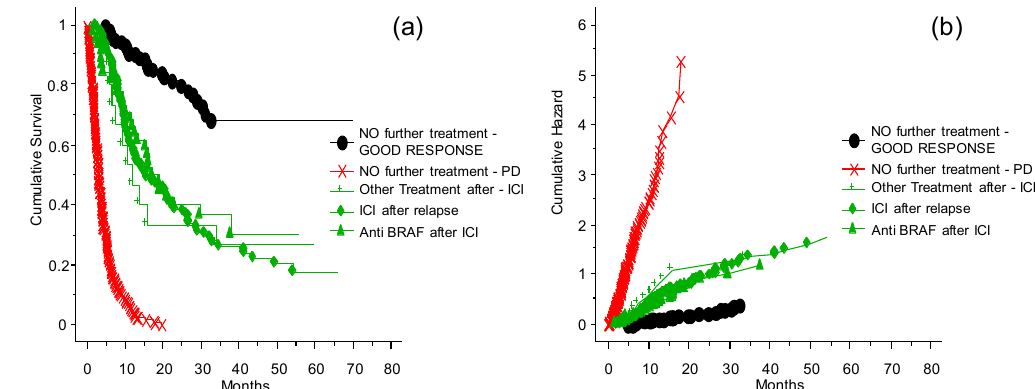
Figure 5. The probability of survival and risk for patients who relapsed after the ICI program at the INT-NA. Panel ( a ) shows probability of survival, panel ( b ) shows risk. Subsequent line of treatment or no further treatment, and comparison between TT given after the ICI program.